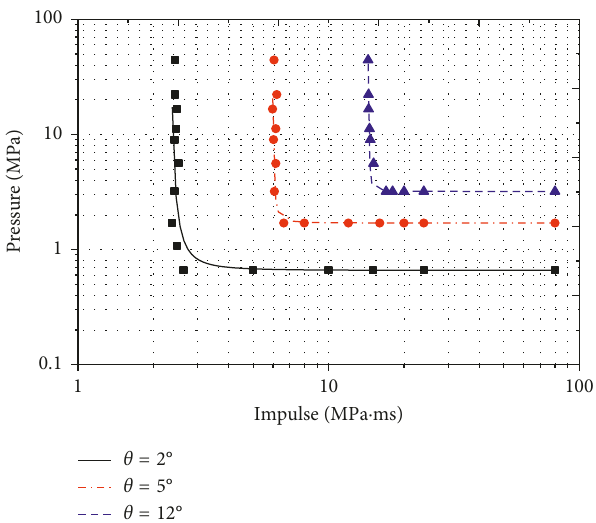
Figure 7: Calculated data and fitting P - I curves.